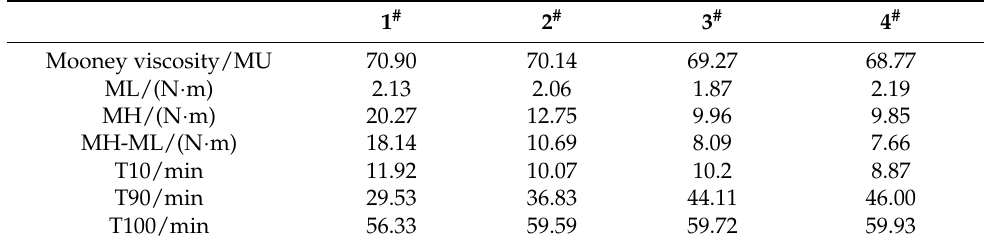
Table 4. Vulcanization characteristics of rubber composites with spent FCC catalyst before modification.